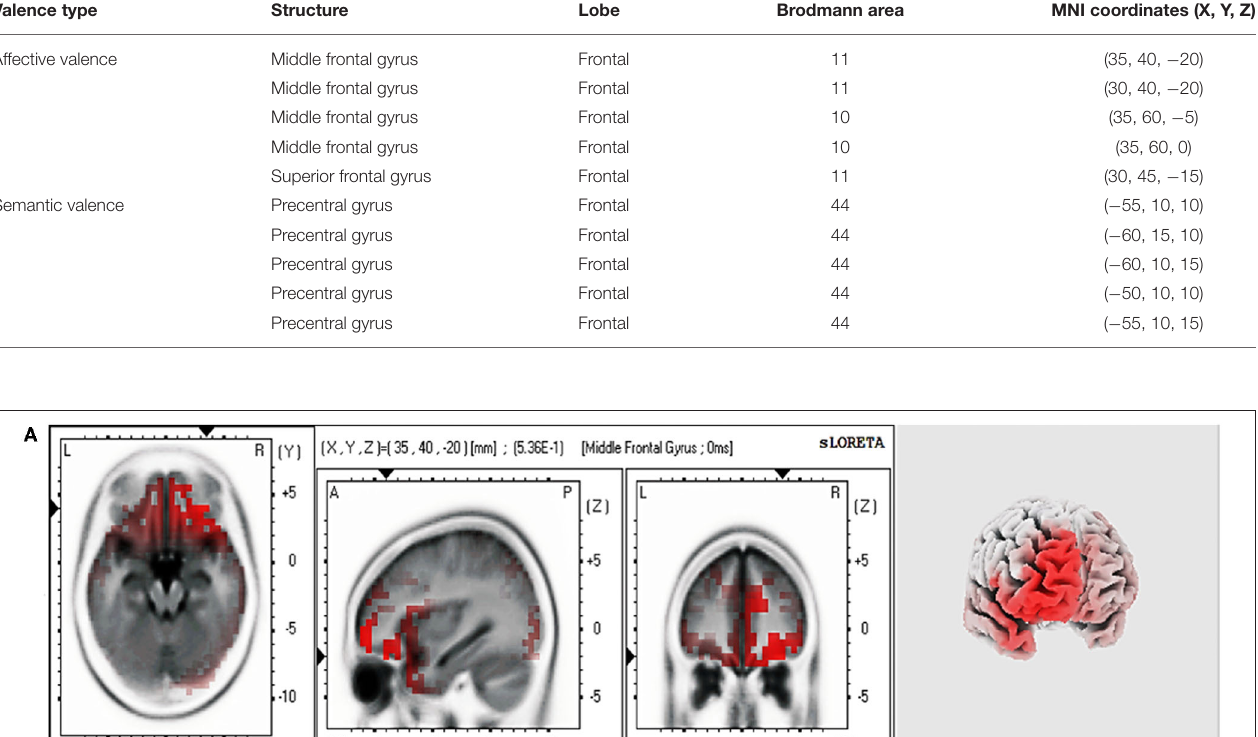
TABLE 4 | Brain regions which showed significant differences in activation between pre-tests and post-tests at the late LPP latency for affective and semantic valence. Valence type